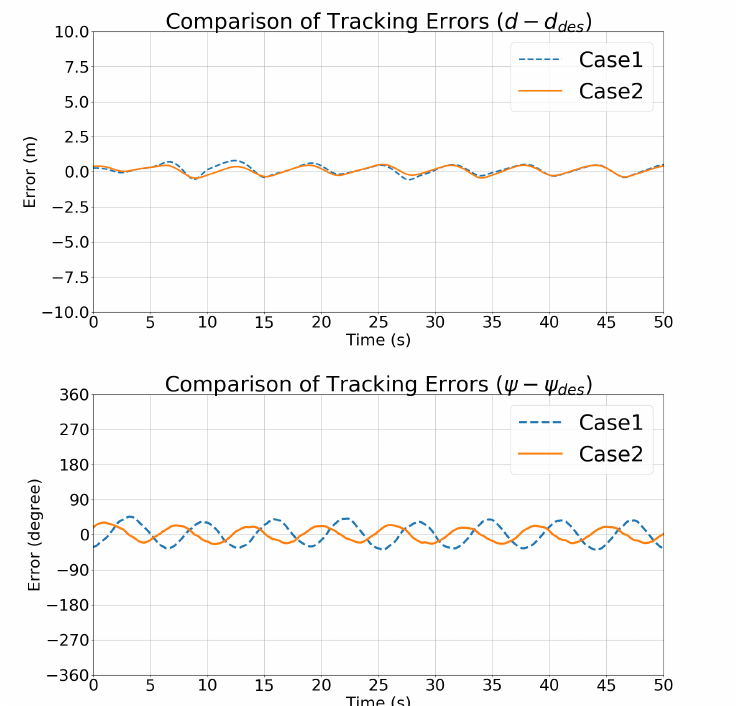
Figure 10. Simulation 1: Comparisons of the state vector tracking errors.